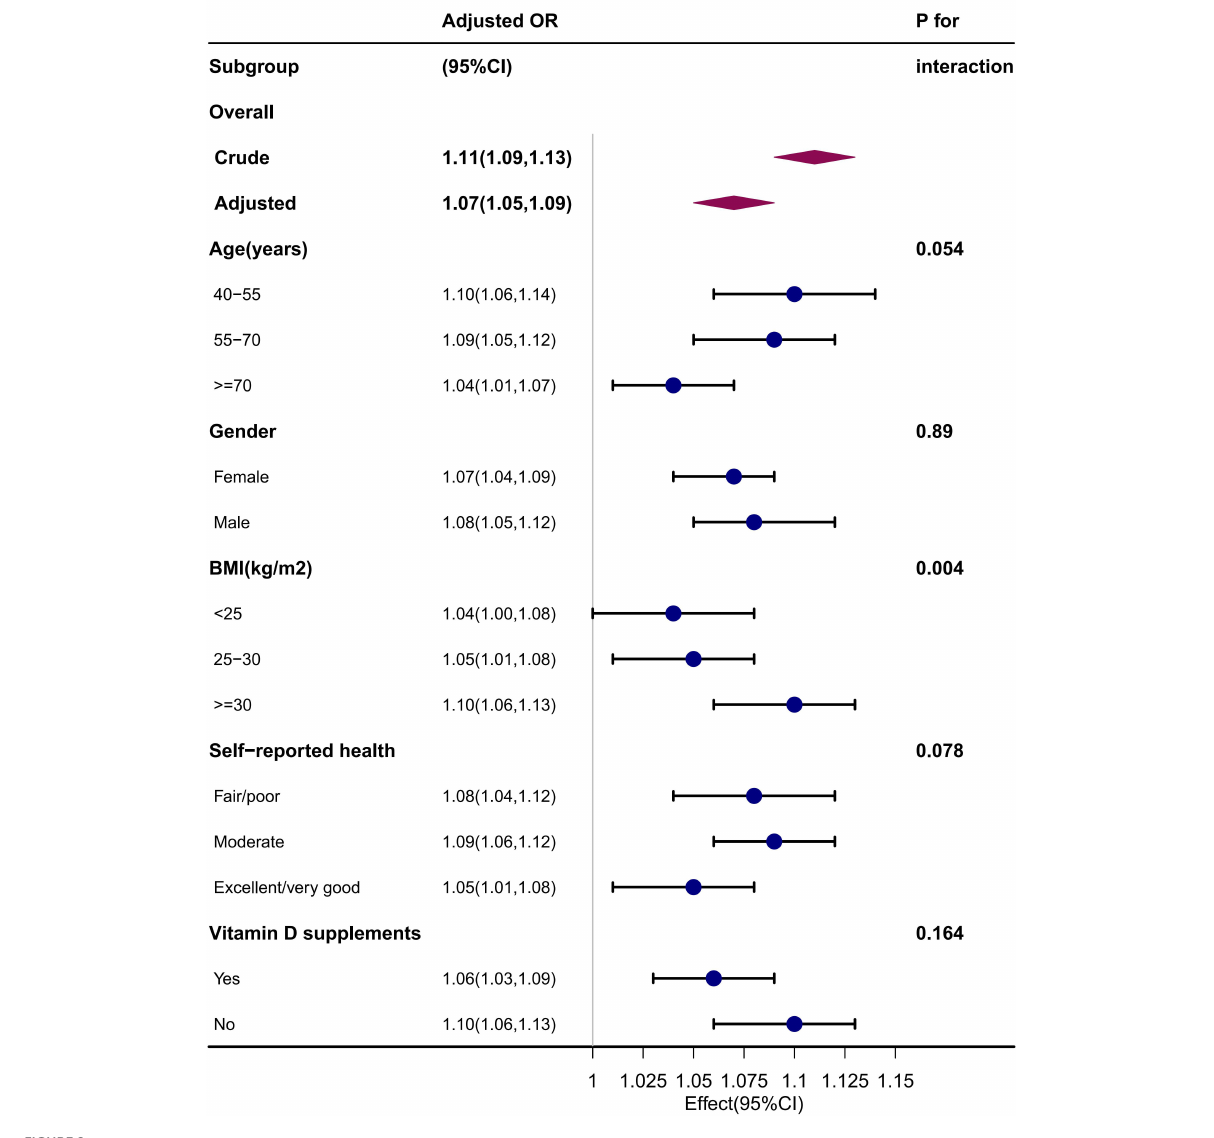
FIGURE2 Subgroup analysis. Adjusted for age, gender, race, education level, PIR, BMI, season of examination, alcohol consumption, smoking status, recreational physical activity, vitamin D supplements, and self-reported